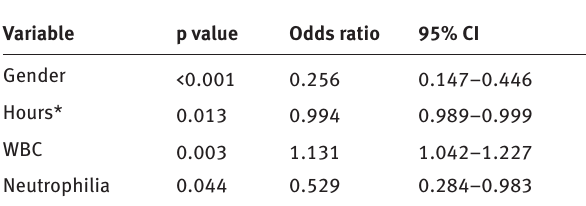
Table 5: Multivariate analysis of diagnostic criteria for acute